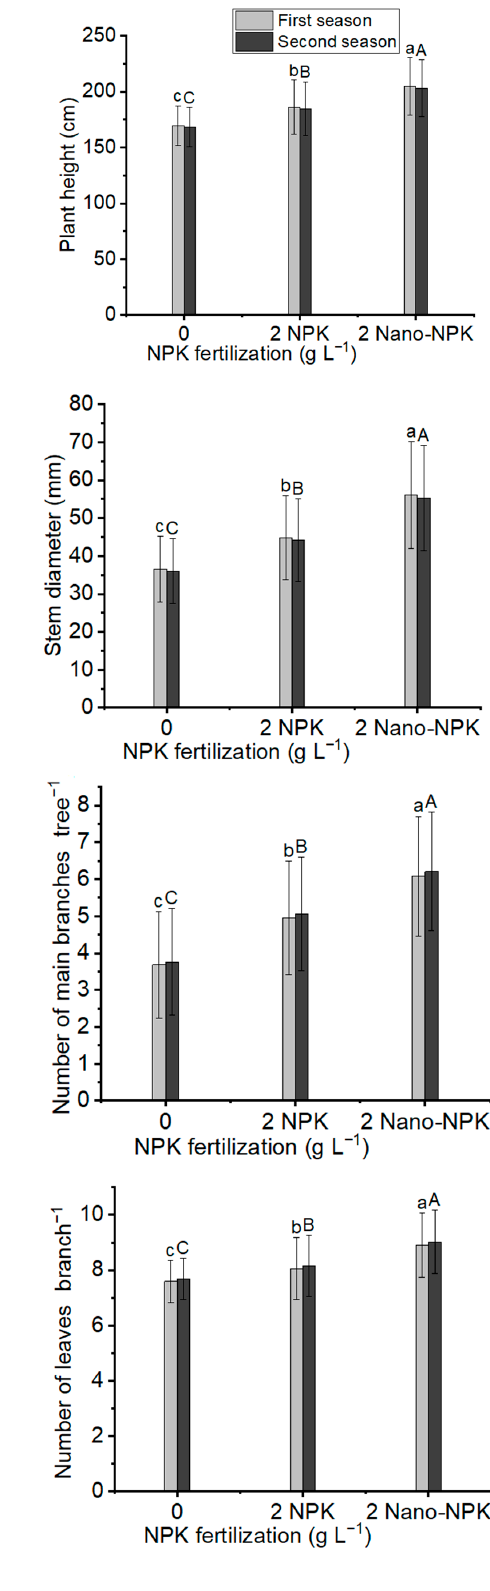
Figure 1. In both seasons of the study, the mean values of plant height (cm), stem diameter (mm), number of main branches tree, and number of leaves per branch of Moringa oleifera trees as influenced by vermicompost and NPK fertilization are provided below. The data are presented as a mean with standard error ( n = 3). Bars with identical lowercase letters are not significant at the 0.05 level of